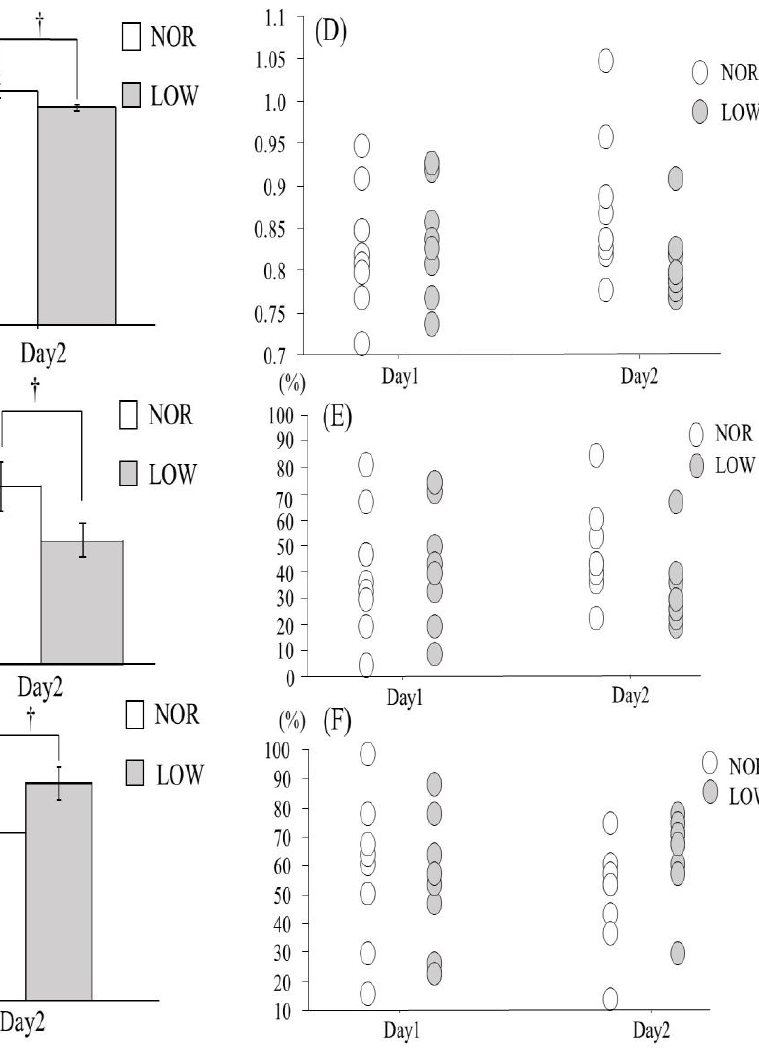
Figure 4. Changes in mean value of RER ( A ), CHO oxidation ( B ), fat oxidation ( C ), individual value ofRER ( D ), CHO Figure4. Changes in mean value of RER (A), CHO oxidation (B), fat oxidation (C) , individual value of- oxidation ( E ) and fat oxidation ( F ). Values are means ± SE. † p < 0.05 vs. RER (D), CHO oxidation (E) and fat oxidation (F) . Values are means ±SE.† p < 0.05vs. trial